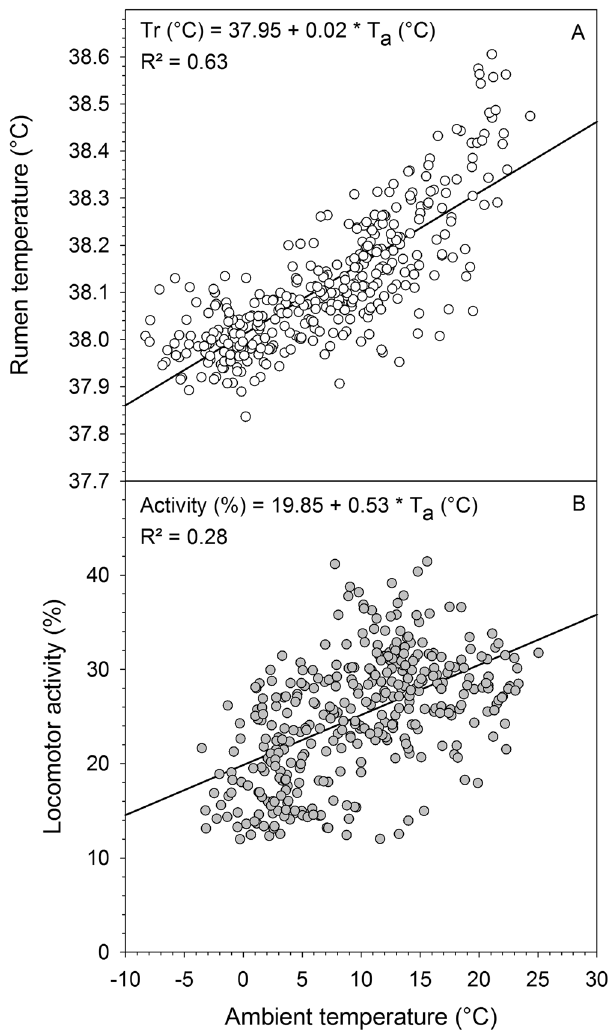
Figure 3. Rumen temperature and locomotor activity in llamas in relation to ambient temperature. Panels show the relationship between average daily ambient temperature (T a ) and average daily rumen temperature (T r , A ) and average daily locomotor activity ( B ) in adult non-pregnant llama dams (N = 7) during one year under Central European